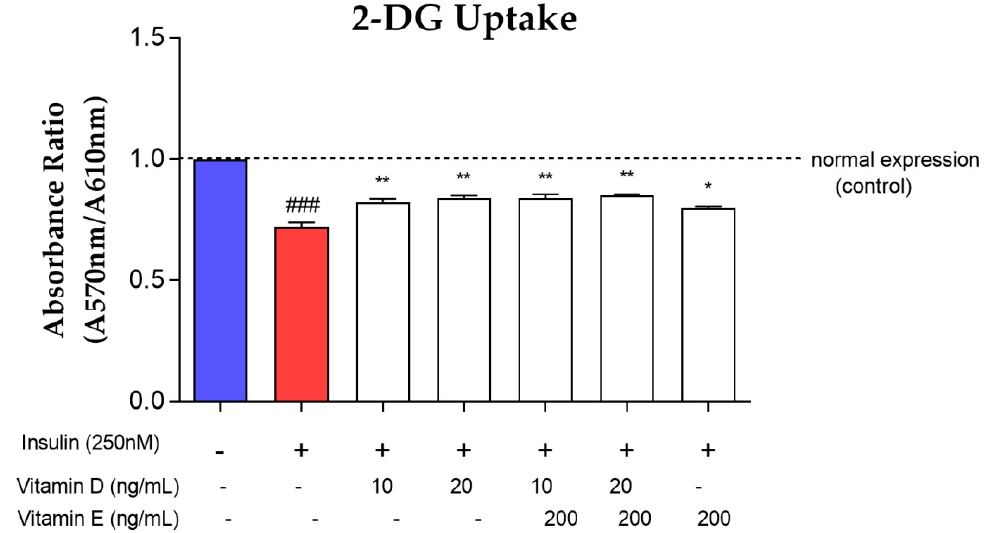
Figure 7. 2-DG uptake level in insulin-resistant cells upon treatment with various concentrations of vitamins D and E. Red bar represents the 2-DG uptake level upon induction with 250 nM insulin for 16 h. White bar represents the 2-DG uptake level upon treatment with vitamins D and E for 24 h after induced with 250 nM insulin. Data were expressed as mean ± SEM of three independent experiments. Significant values were expressed as * p < 0.05, ** p < 0.01 compared to the negative control group and ### p < 0.001 compared to the control group.